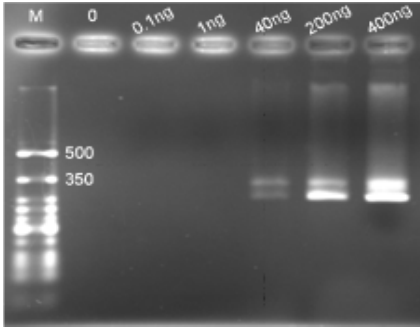
Figure 9. The agarose electrophoresis of the H5 AIV analytes for the sensitivity test. Channels M: ss DNA marker. Referring to the marker, the top band of each channel indicated that H5 AIV ss DNA was present, whereas the bottom band indicated ds DNA. The signals can be clearly recognized down to 40 ng.